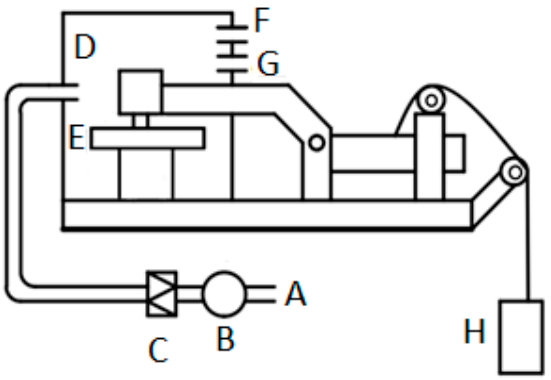
Figure 1. Schematic of test equipment. Ambient air ( A ), fan ( B ), HEPA filter ( C ), air inside the chamber ( D ), rotating disc sample ( E ), air outlet to Impactor PM10 ( F ), air outlet to the OPS ( G ) and weight ( H ).